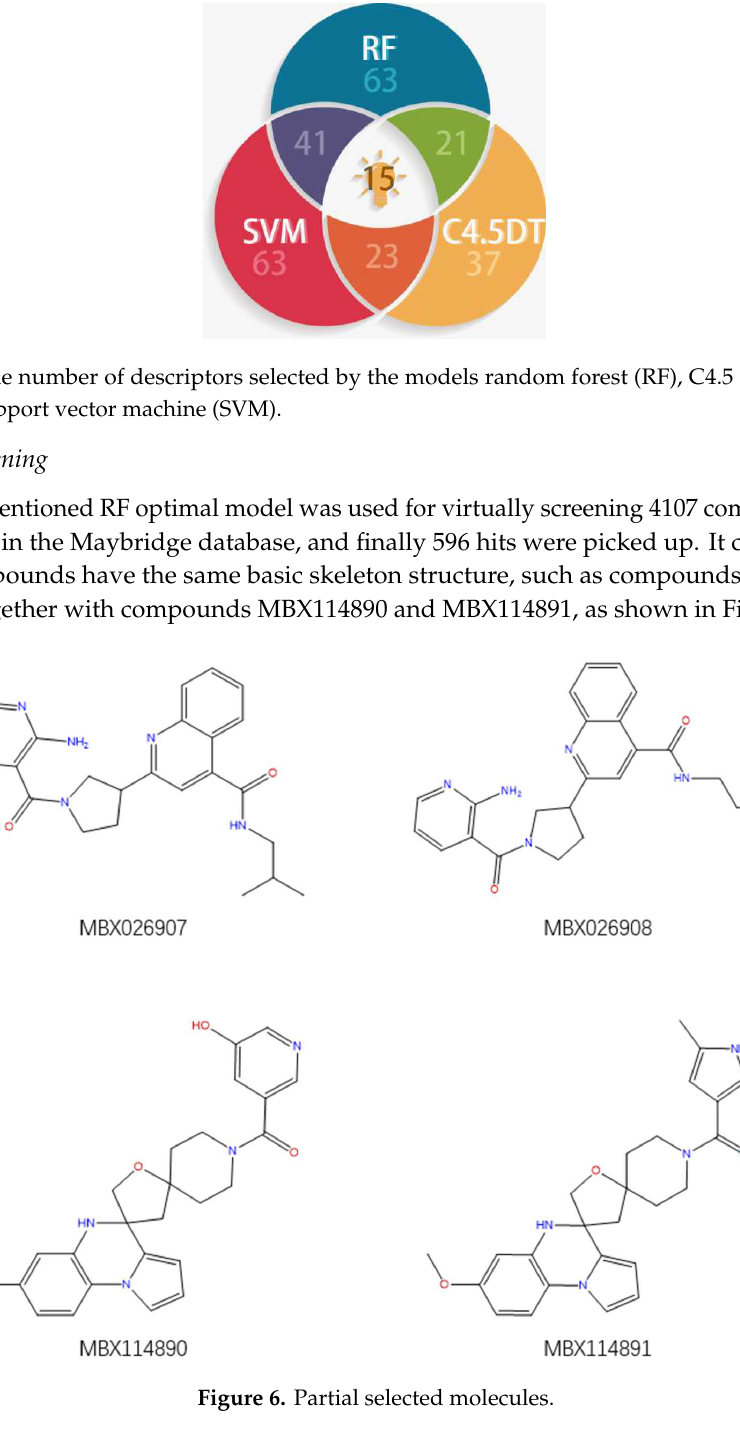
Figure 4. The relative importance of the 10 highest ranking descriptors in the optimal random forest (RF) model.